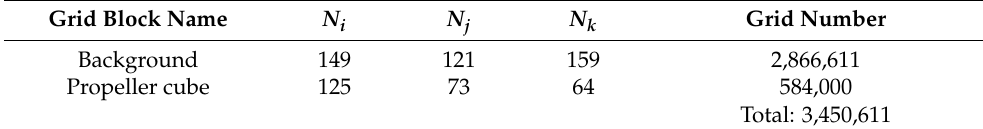
Table 2. Boundary conditions.